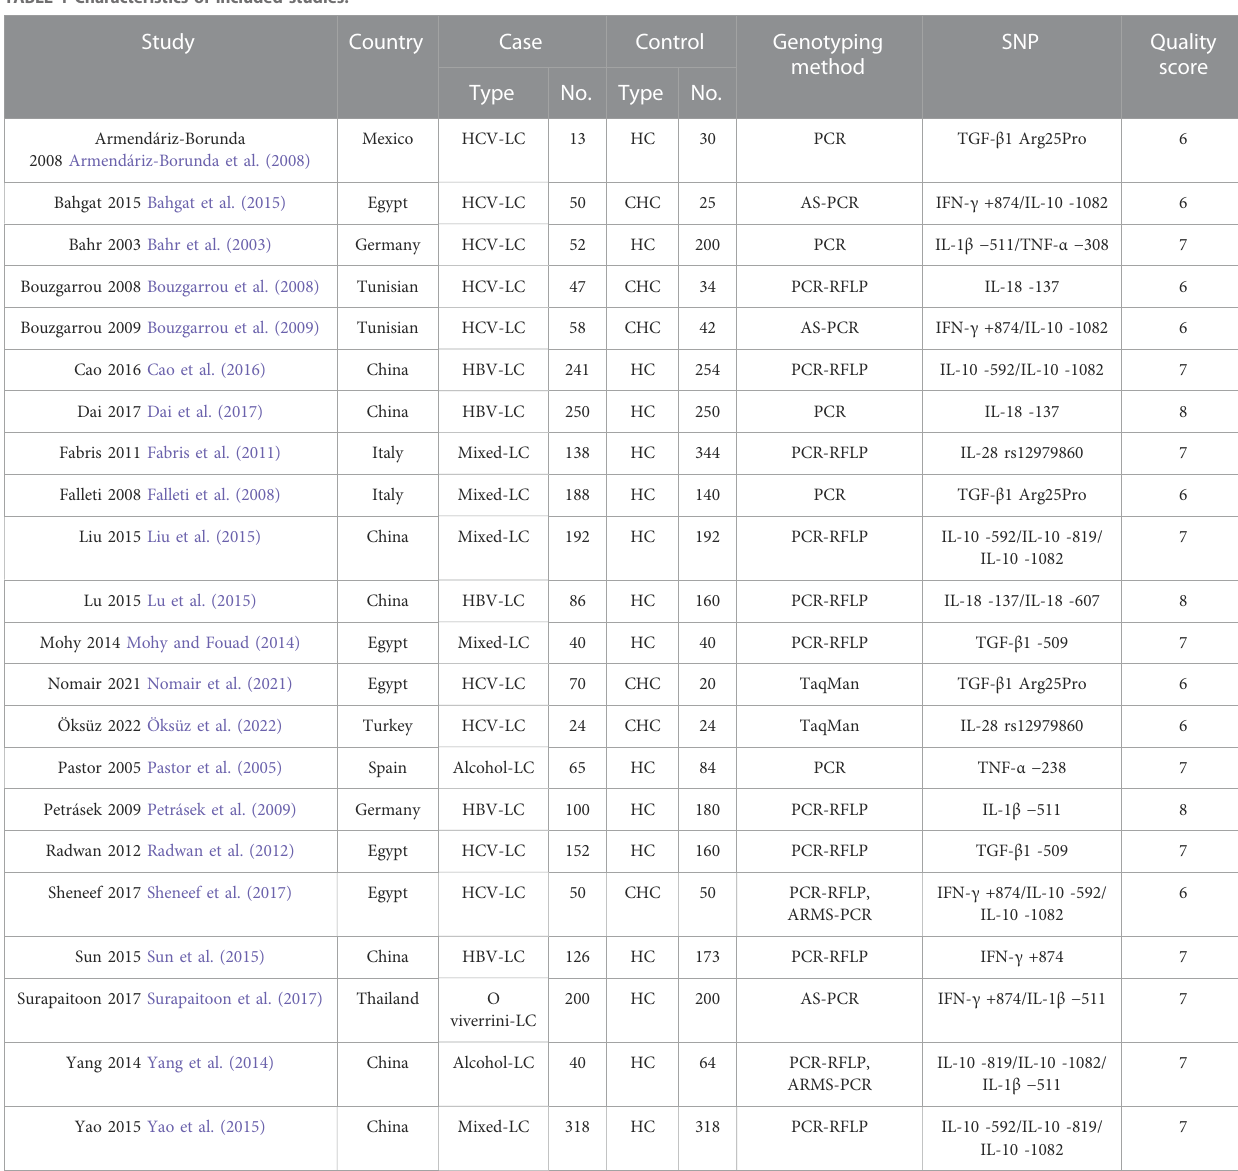
TABLE 1 Characteristics of included